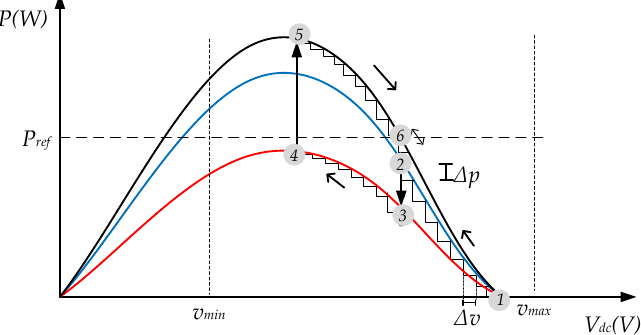
Figure 9. RPPT operation in a PV generator. (1) Initial point. (2) Point of operation by using the algorithm. (3) Change of point of operation because of solar irradiance. (4) New maximum power point. (5) Reduce of power. (6) Reference of active